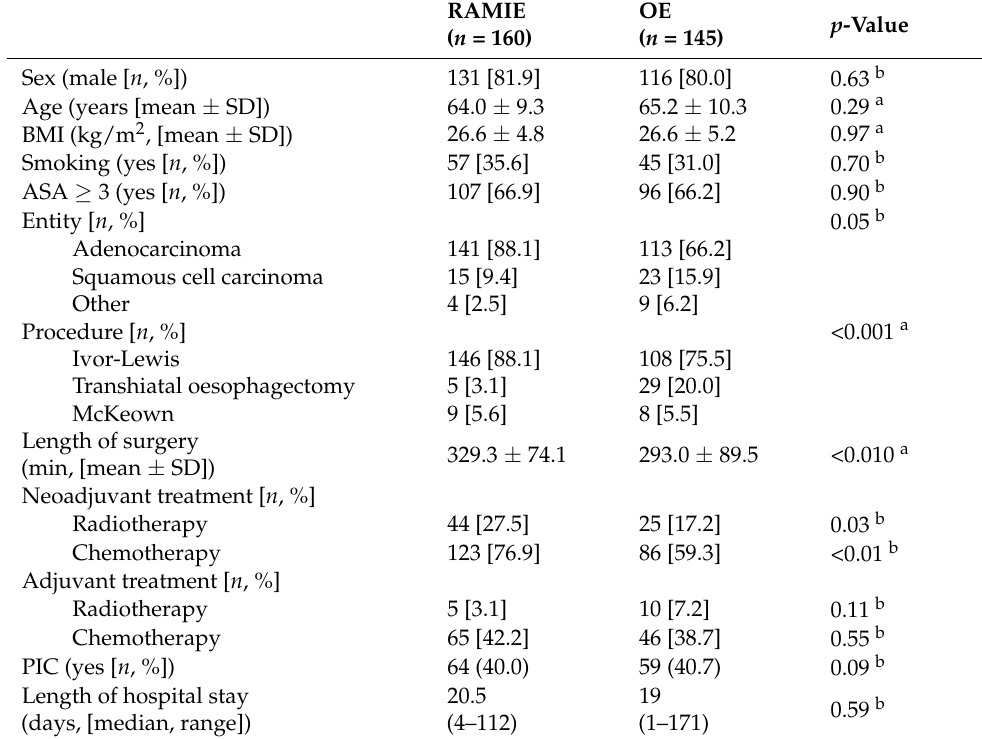
Table 1. Baseline characteristics of patients undergoing RAMIE ( n = 160) or OE ( n = 145) stratified by surgical approach. Data are presented as mean ± SD, range or relative frequencies. Continuous variables were tested using a Students’ t -test (normally distributed) and b Mann-Whitney-U test (non-normally distributed). ASA: American Society of Anaesthesiologists; BMI: body mass index, OE: open esophagectomy, PIC: postoperative infectious complications; POD: postoperative day; RAMIE: Robot-assisted minimally-invasive esophagectomy, SD: Standard deviation. p -values < 0.05 were considered statistically significant and are indicated in